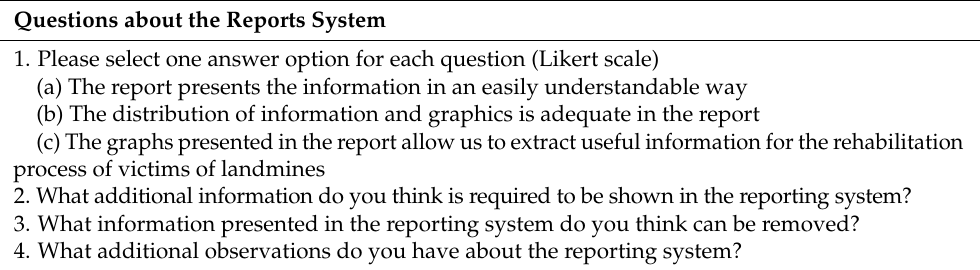
Table 4. Survey for health professionals: reports system.